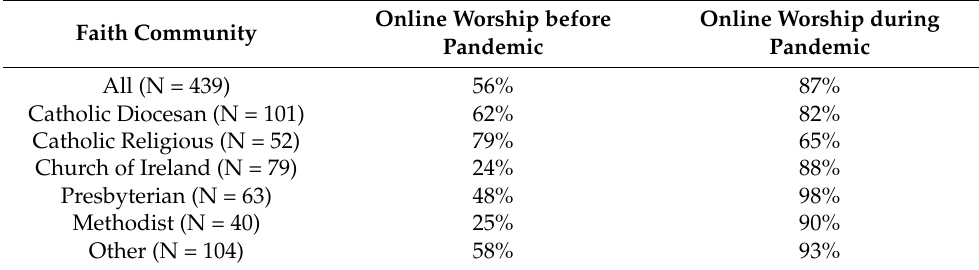
Table 1. Provision of online worship by denomination, before and during the pandemic. Online Worship before Online Worship during Faith Community Pandemic